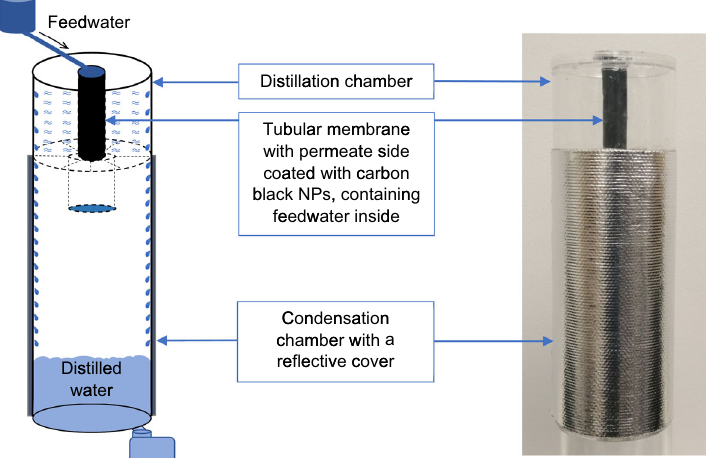
Fig. 2 The schematic and photograph of the tubular passive permeate-side-heated solar membrane distillation system. The tubular system was placed vertically during operation. The inner dimensions of this system are as follows: feedwater chamber (i.e., inside of the tubular membrane) [50 mm (H), 16 mm (D)], distillation chamber [50 mm (H), 70 mm (D)], condensation chamber [158 mm (H), 70 mm (D)]. The tubular membrane had the dimensions of 50 mm × 50 mm before rolling. The volume of the distillation chamber and the inner surface area